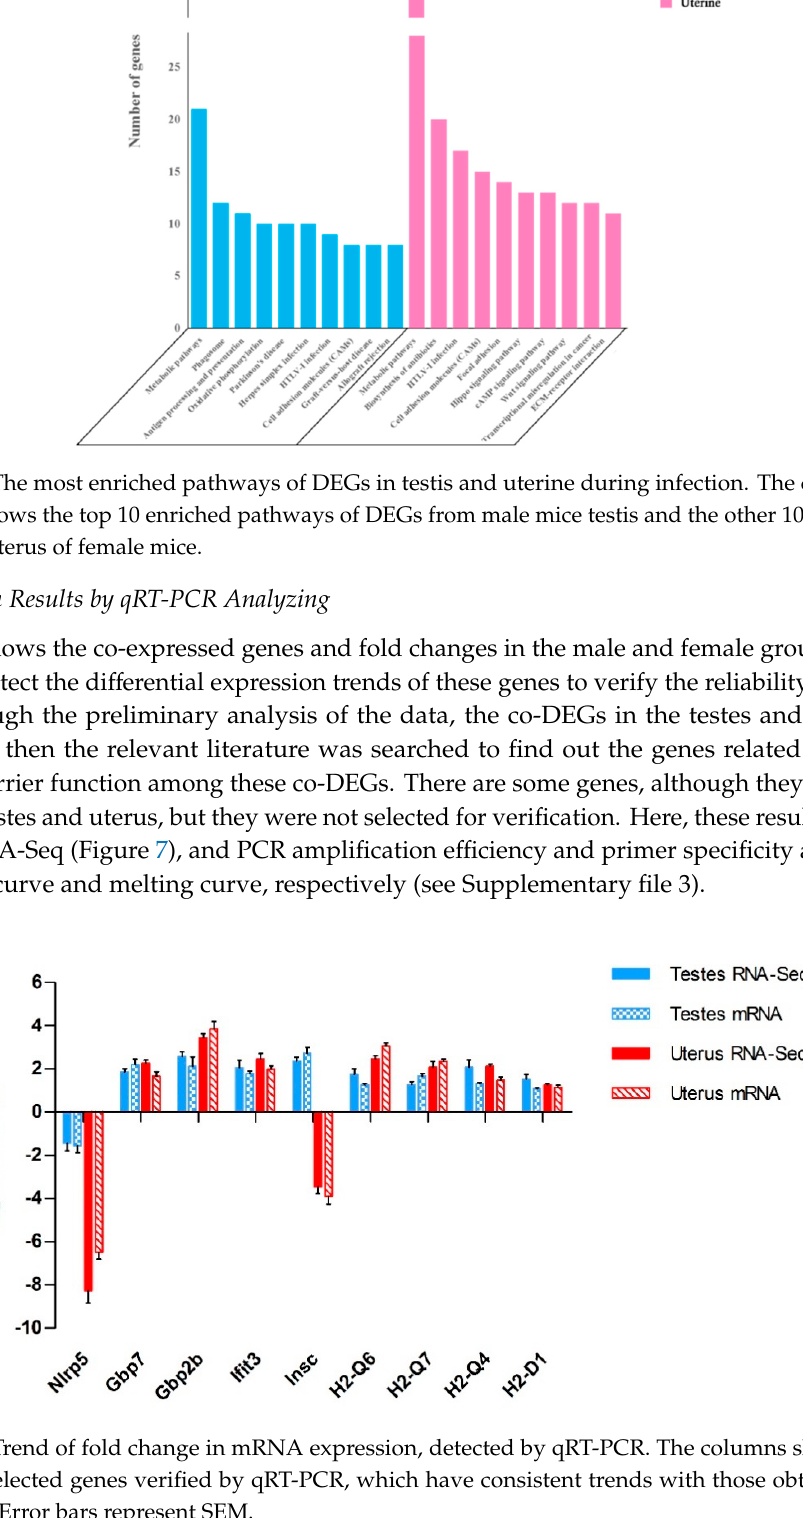
Figure 7. Trend of fold change in mRNA expression, detected by qRT-PCR. The columns show that the nine selected genes verified by qRT-PCR, which have consistent trends with those obtained by RNA-seq. Error bars represent SEM.